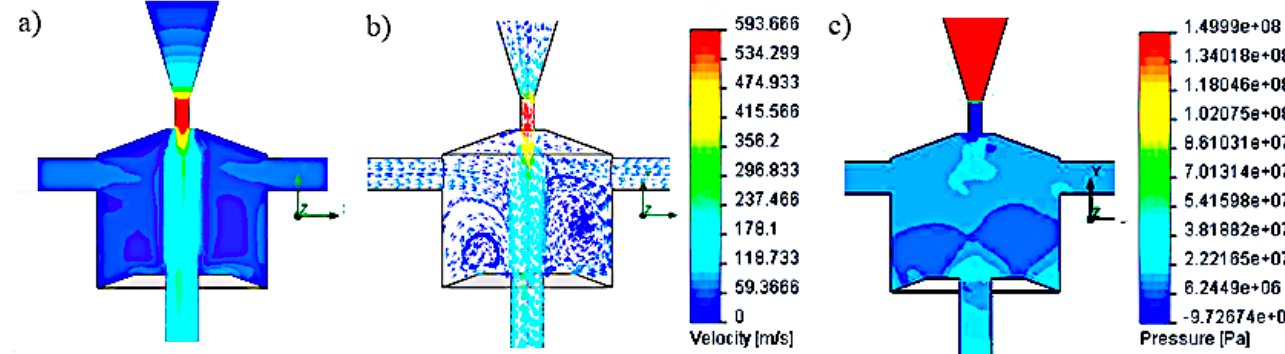
Figure 5. Distribution test results: ( a , b ) speed and ( c ) pressure inside the self-excited pulse head with side openings perpendicular to the swirl